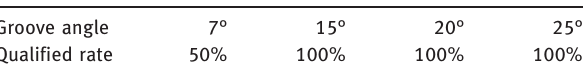
Table 3: Results of the bending test of T92/Super 304H dissimilar weld joints.